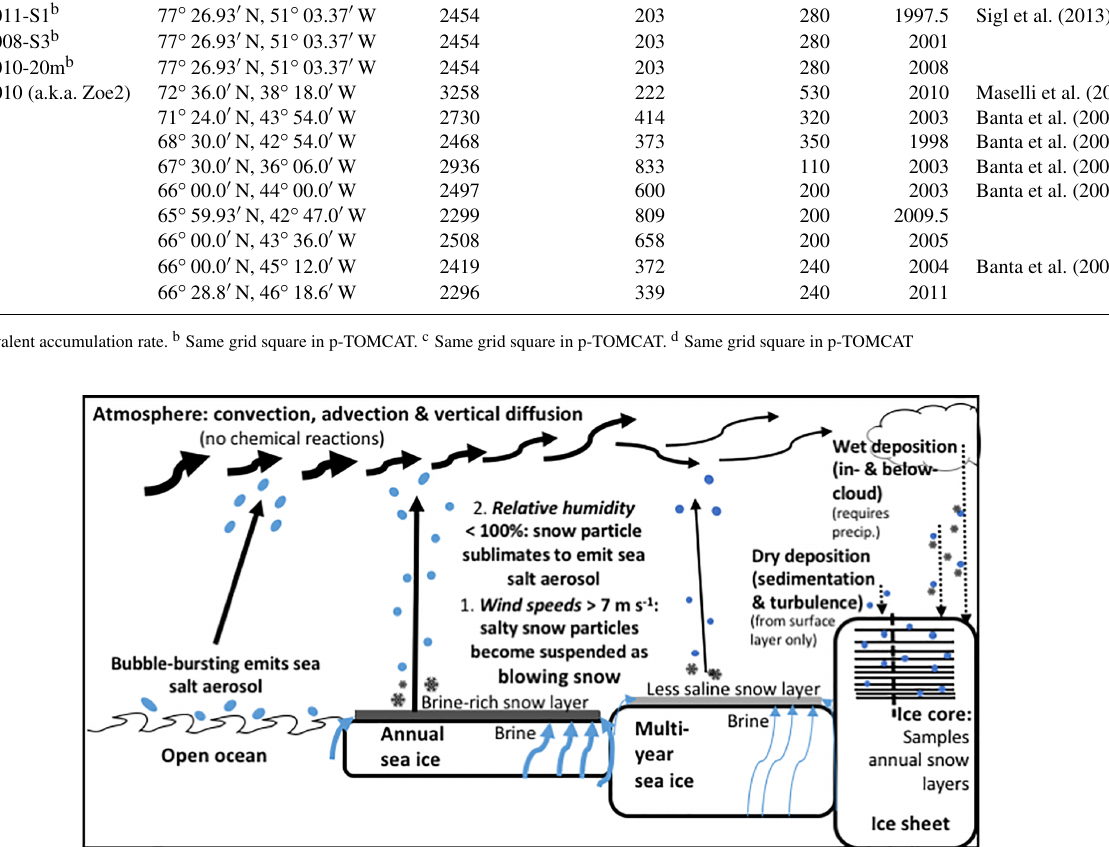
late snow particles splitting into multiple individual sea salt aerosol (see Huang and Jaeglé,